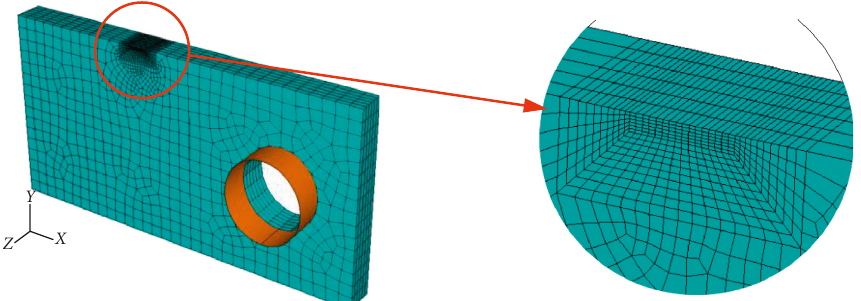
Figure 3: Mesh model: (a) global mesh; (b) mesh refinement on crack tip.